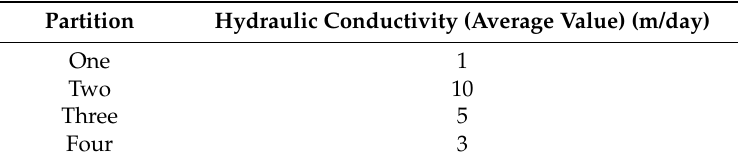
Table 1. Hydraulic conductivity in each zone of the